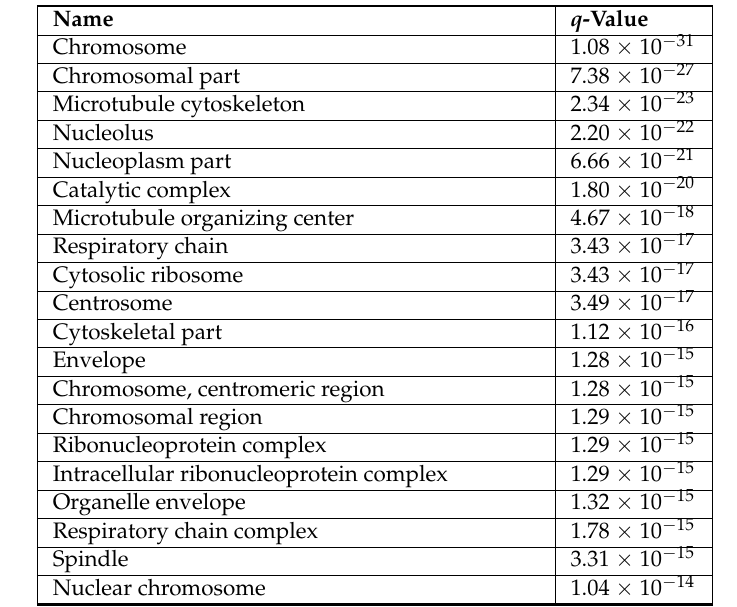
Table 5. ToppFun functional enrichment analysis—Cellular Component (CC). The top 20 significant CC terms are shown